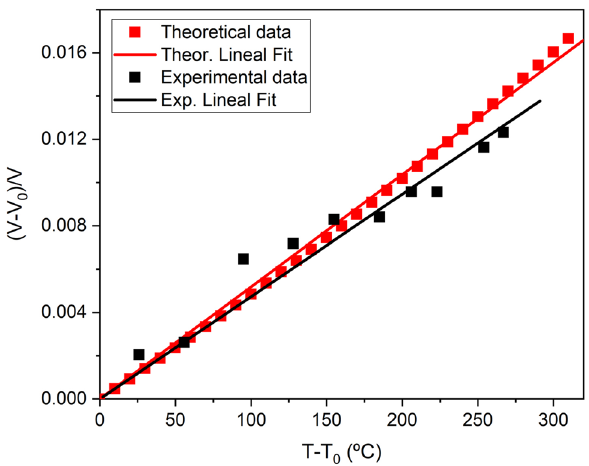
Figure 5. Evolution of the experimental (black) and theoretical (red) relative volume change of BaCa(CO 3 ) 2 barytocalcite at ~ 3 GPa as a function of temperature. The slope of the linear fit (solid line) provides an estimation of the average thermal expansion for barytocalcite between 20 and 300 ºC.